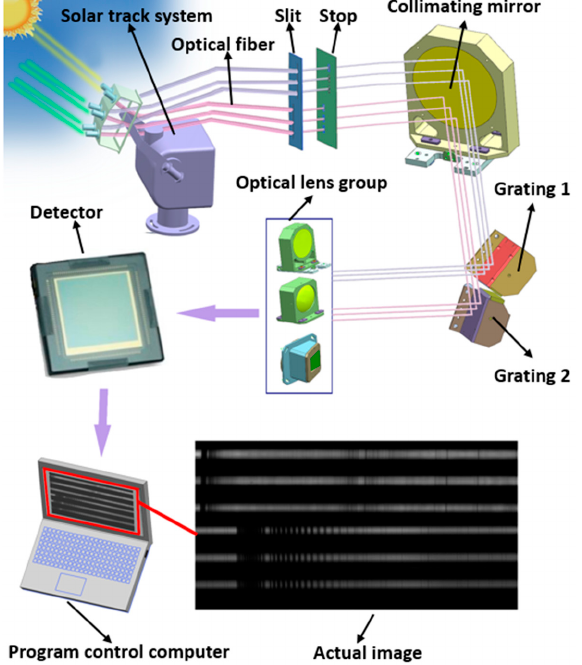
Remote Sens. 2022 , 14 , x FOR PEER REVIEW Figure 11. The working principle of DGSS along the light trail. Figure 11. The working principle of DGSS along the light trail.